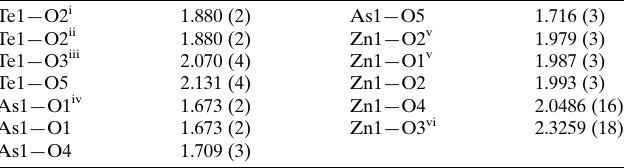
Table 1 Selected bond lengths (A˚ ).